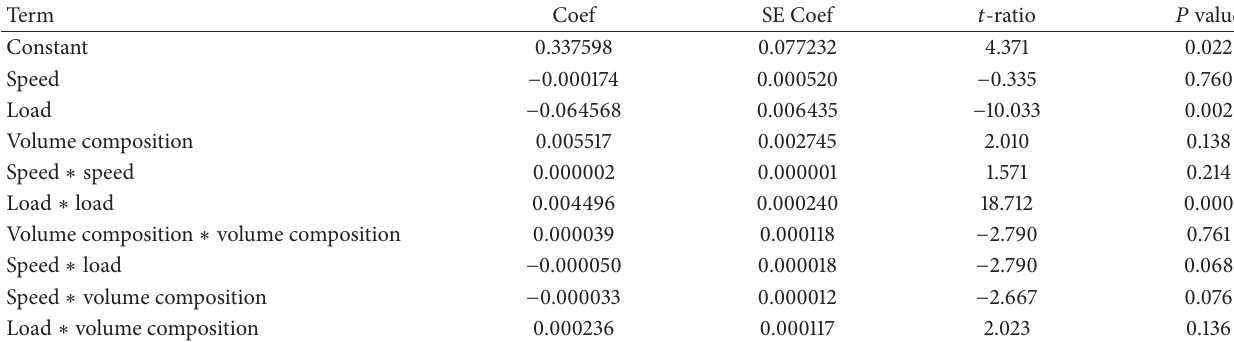
Table 8: Estimated regression coefficients for